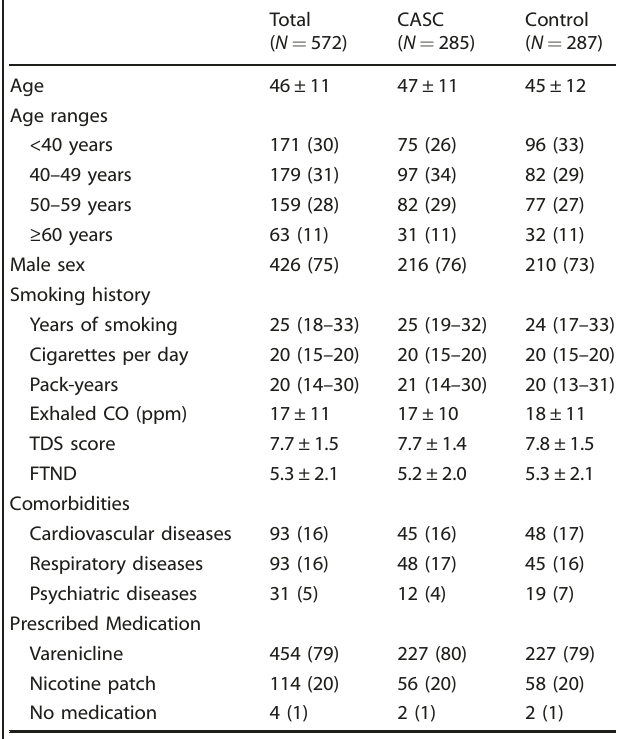
Table 1. Baseline characteristics of the trial